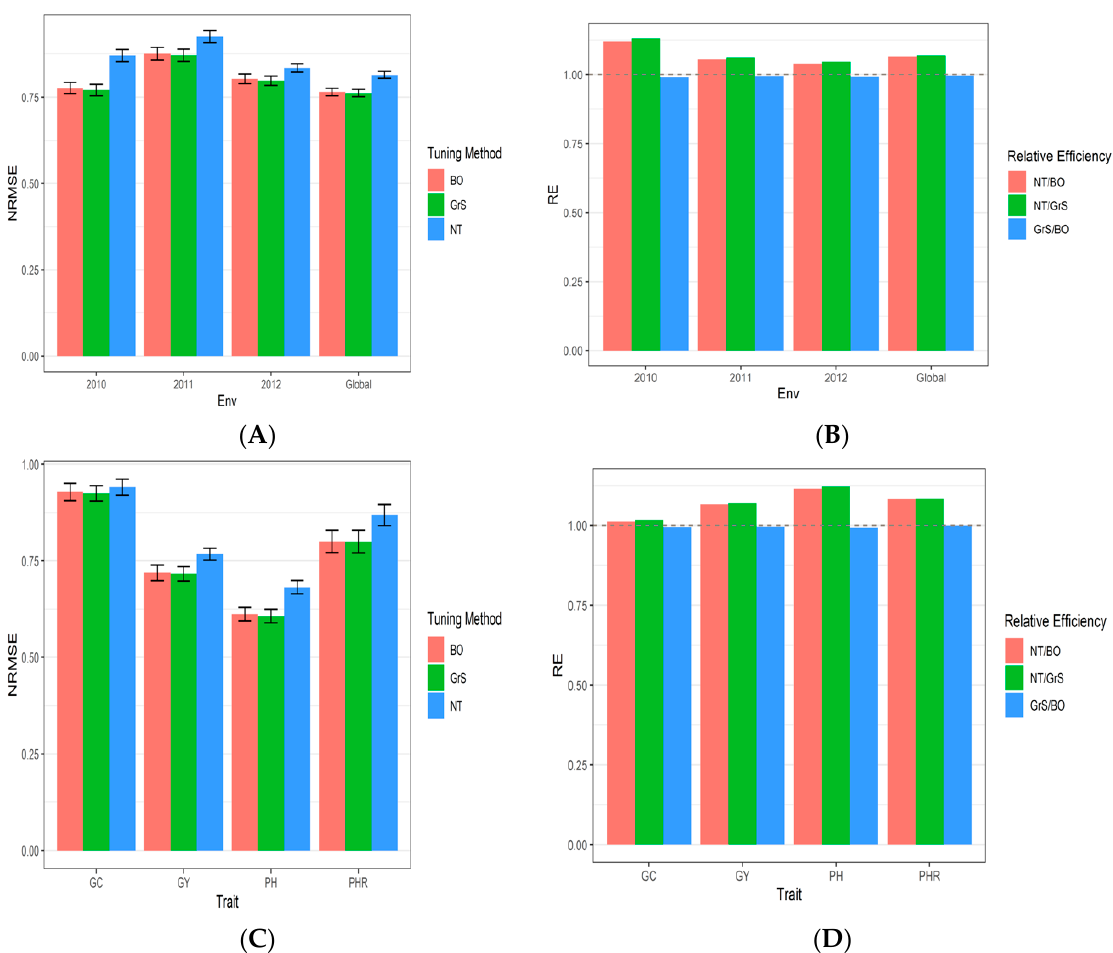
Figure 2. ( A ) Prediction performance for dataset 2, Indica dataset in terms of normalized root mean squared error (NRMSE) for each year (2010–2012) across traits (CG, GY, PH and PHR), across years and across traits (Global) with three strategies of tuning (BO, GrS and NT) under 7 Fold Cross-Validation (7FCV). ( B ) The relative efficiency for each environment (2010–2012) across traits and across environments and across traits (Global) with three strategies of tuning (BO, GrS and NT) under 7 Fold Cross-Validation (7FCV). ( C ) Prediction performance in terms of normalized root mean squared error (NRMSE) for each trait (CG, GY, PH and PHR) across years with three strategies of tuning (BO, GrS and NT) under 7 Fold Cross-Validation (7FCV). ( D ) The relative efficiency for each trait (CG, GY, PH and PHR) across environments with three strategies of tuning (BO, GrS and NT) under 7 Fold Cross-Validation (7FCV). When RE > 1 the denominator method outperforms the numerator in terms of prediction